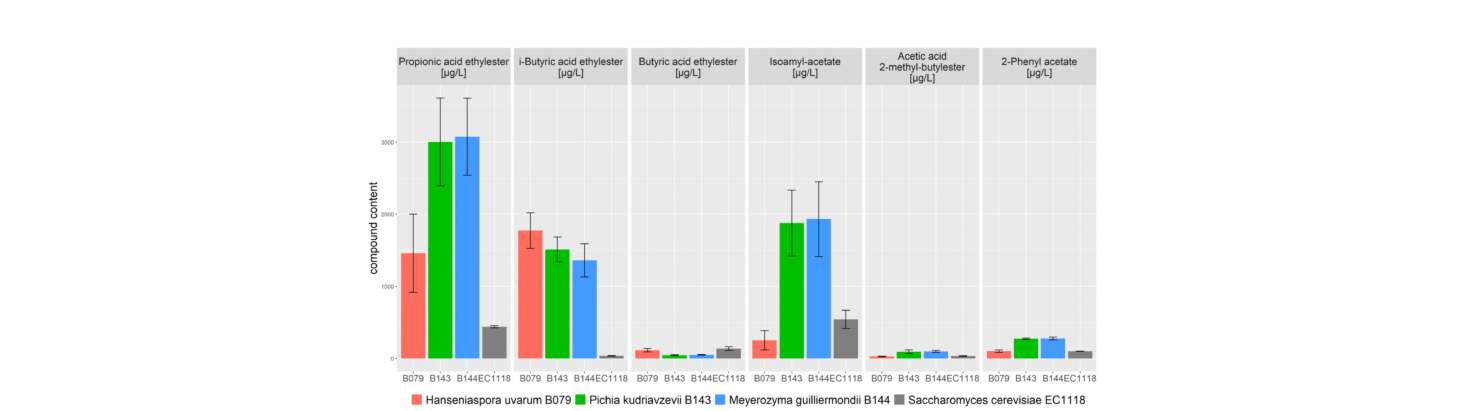
Figure 6. Ester aroma compound formation of non-conventional yeasts compared to the EC1118 wine yeast. Aroma compounds were quantified by gas chromatography at the end of fermentation (see Figure